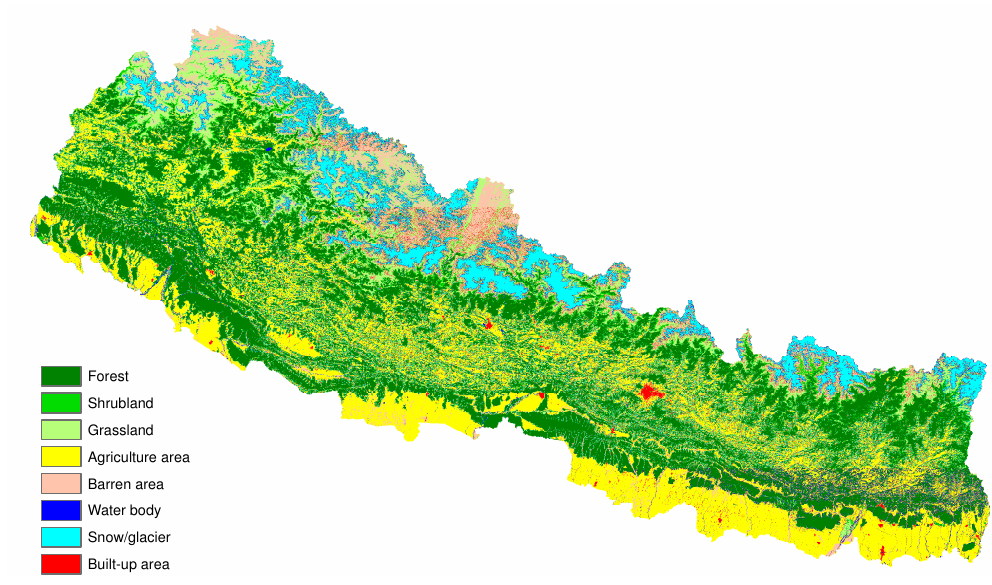
Figure 2. Land cover map of Nepal in